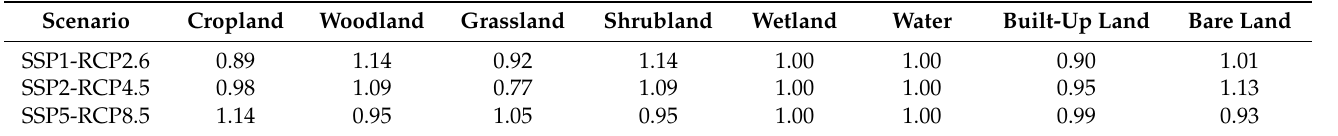
Table 4. Weights of land use types in different